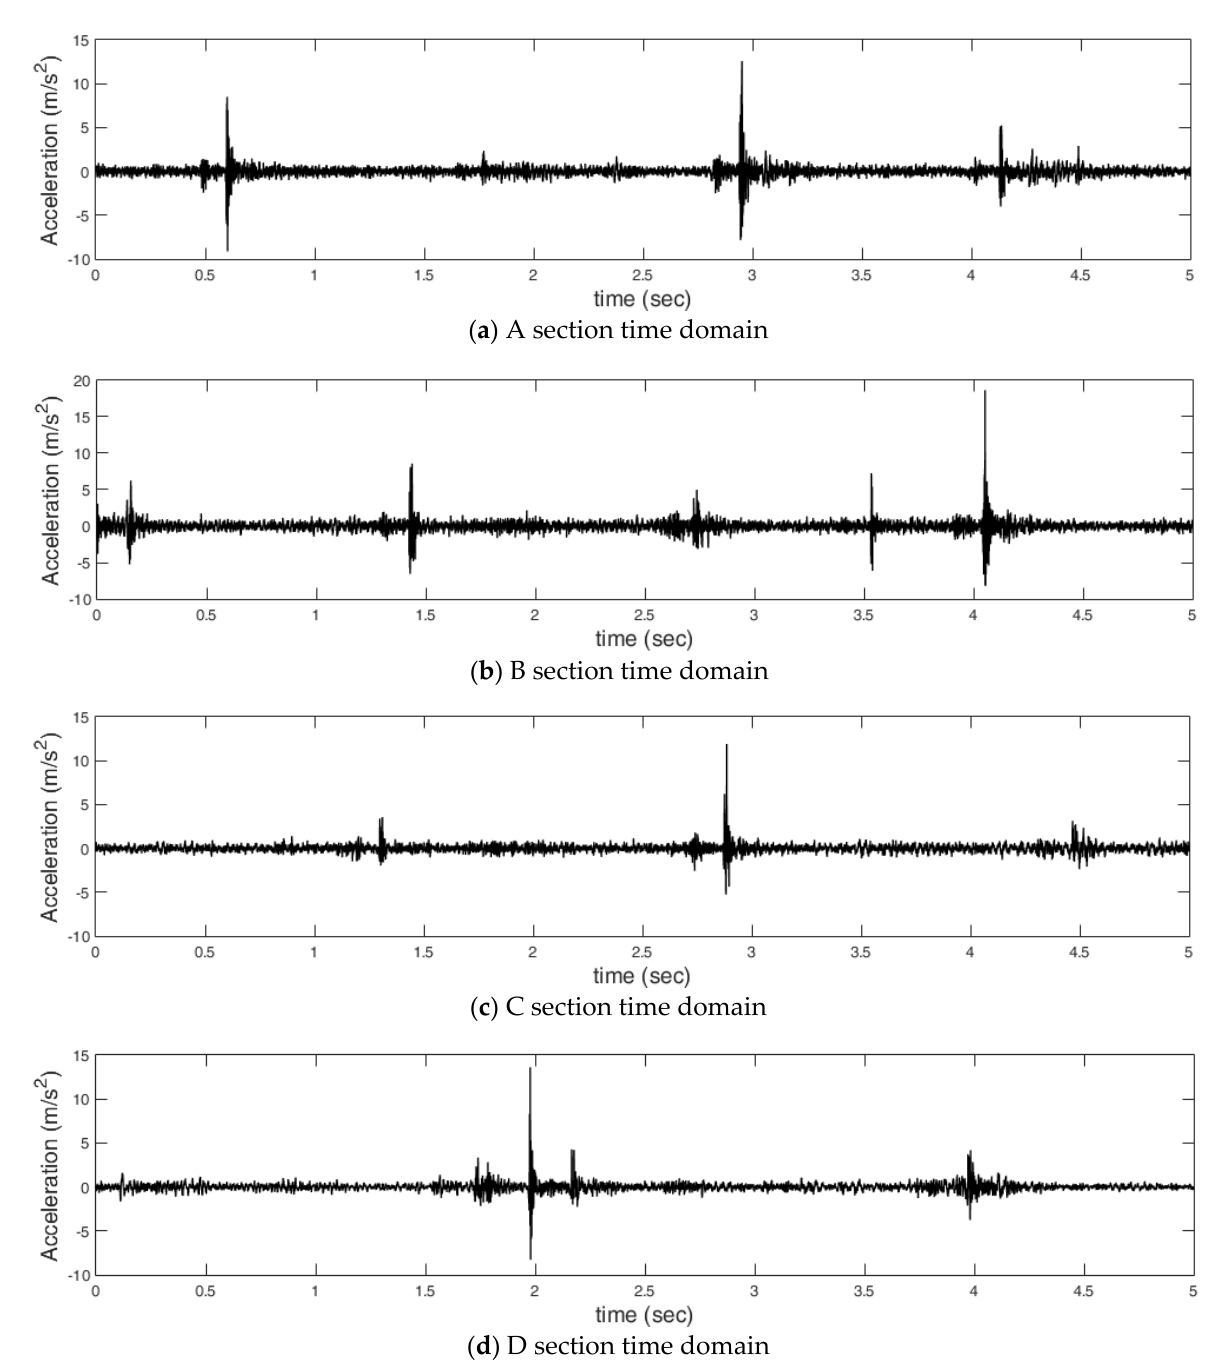
Figure 5. Data obtained from measurement system.